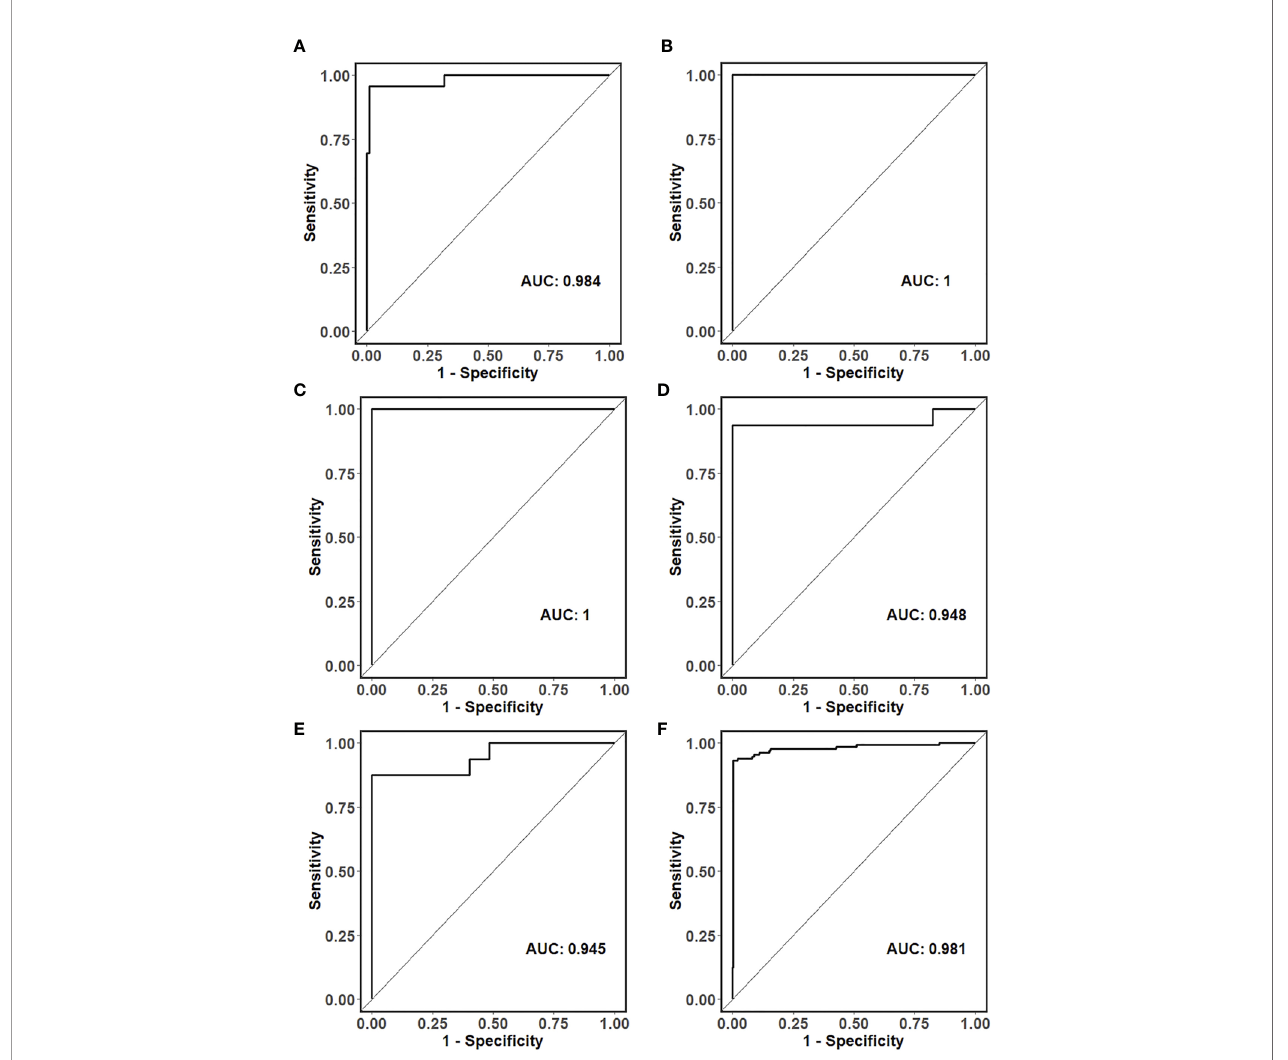
FIGURE 2 | ROC curves for the classi fi cation of the tissue of origin in (A) colorectal, (B) ovarian, (C) breast, (D) neuroendocrine, (E) pancreatic and (F) all liver metastatic